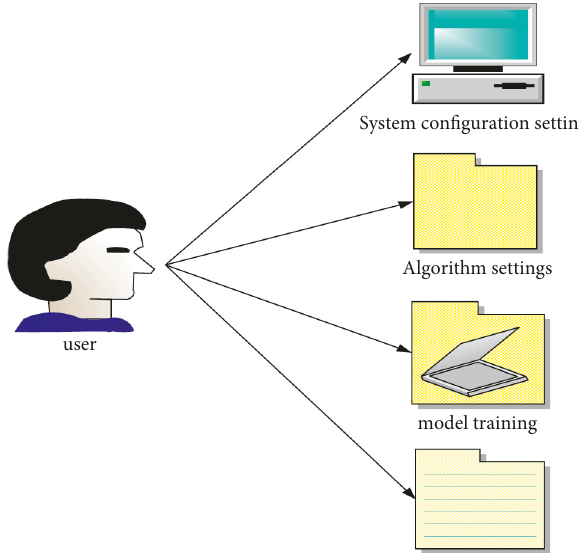
Figure 6: System use